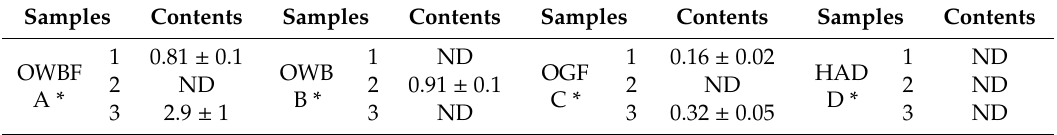
Table 1. The contents of BaP in breast skin samples from supermarkets ( µ g / kg, n = 3).